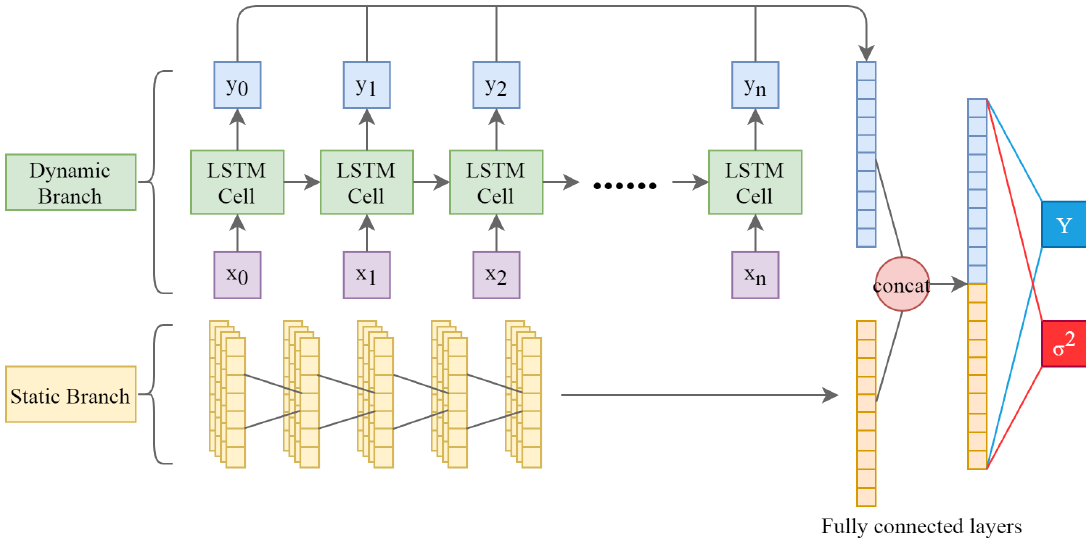
Figure 4. Overall structure of the deep learning model for wheat yield